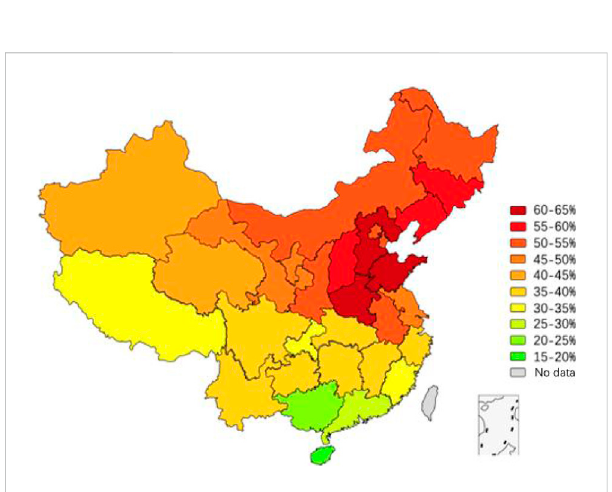
FIGURE 3 Vector map showing the T allele distribution of MTHFR C677T in Chinese women.